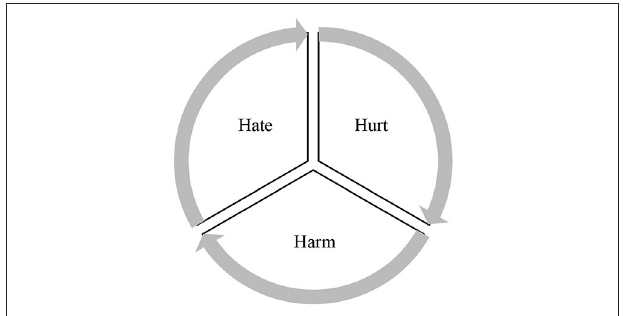
FIGURE 2 | The negative 3-H trio of